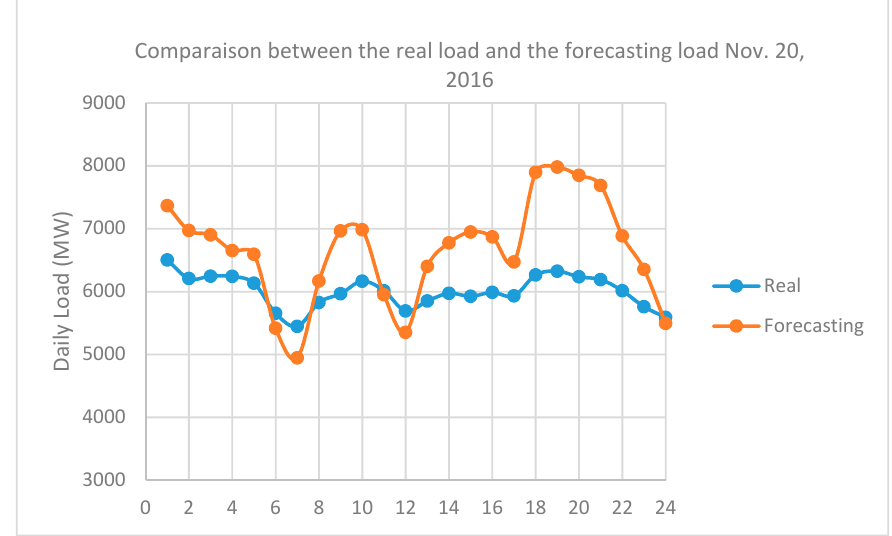
Figure 16. The pattern correlation between the previous similar day of Nov 20, 2016.